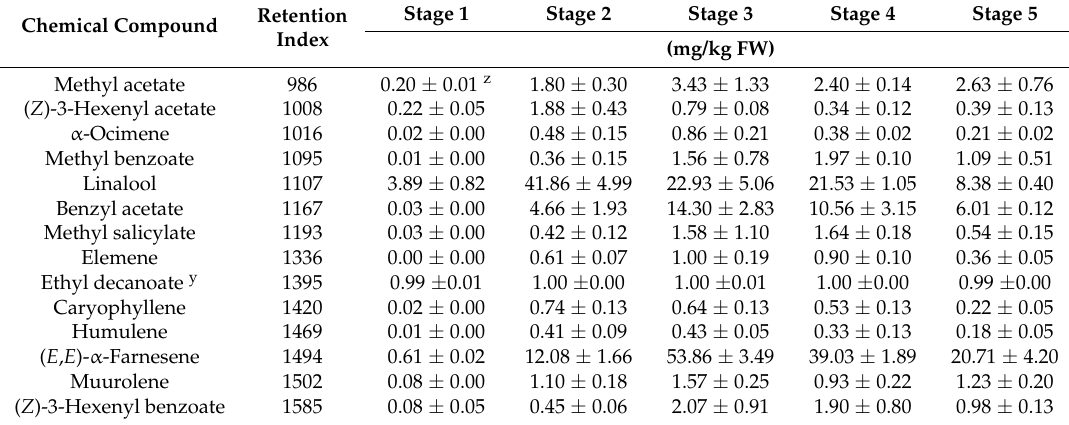
Table 1. Volatile organic compounds emitted from living flowers of Jasminum sambac ‘Bifoliatum’ plants from stage 1 (the bud stage: petals close together) to stage 5 (flower started senescence). Chemical Compound